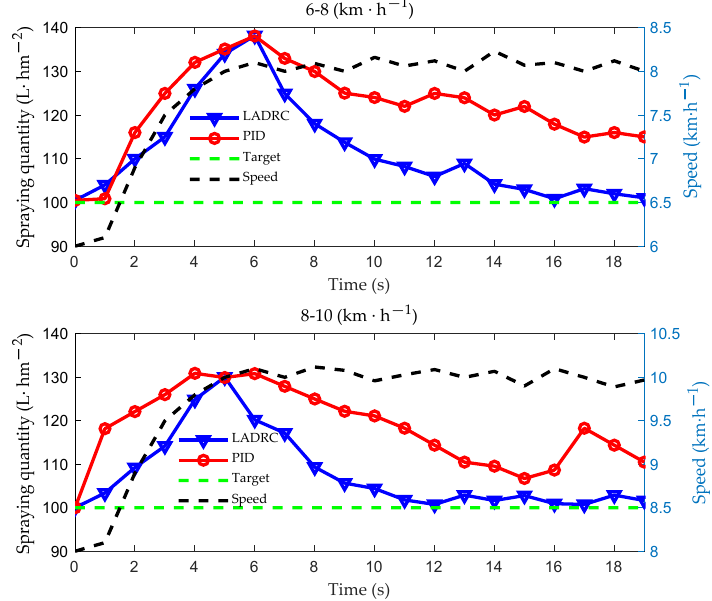
Figure 14. Field spray quantity data curve (accelerated motion).